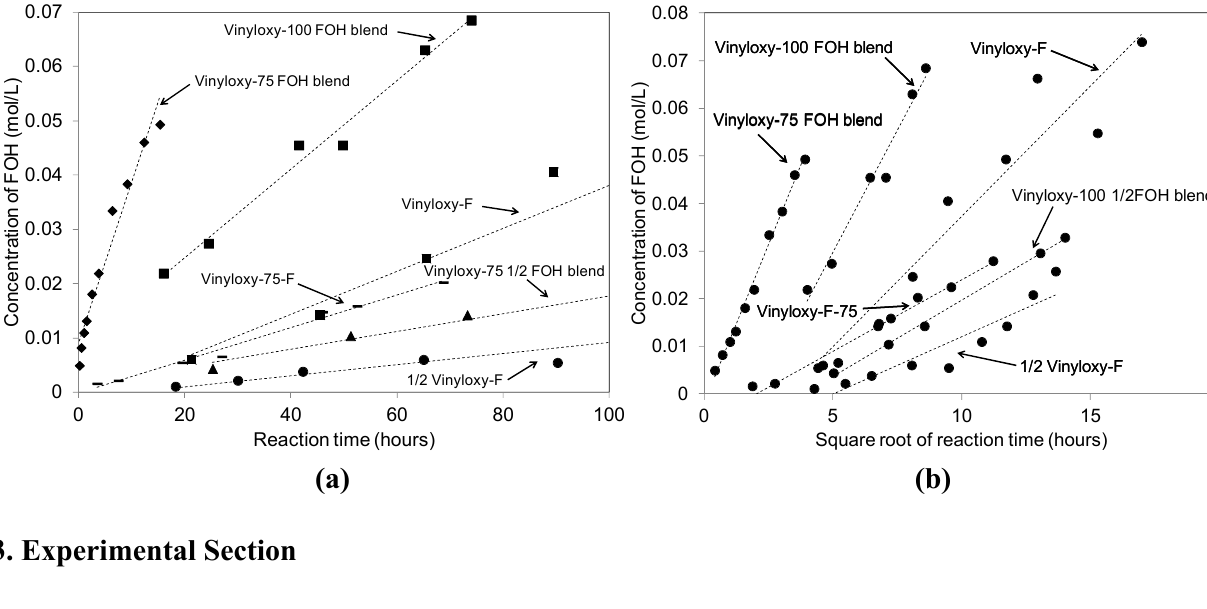
Figure 7. ( a ) comparison among the initial rates obtained from the concentration versus time plots for each of the six fluorine-modified systems; ( b ) representative plots for the Higuchi treatment on the